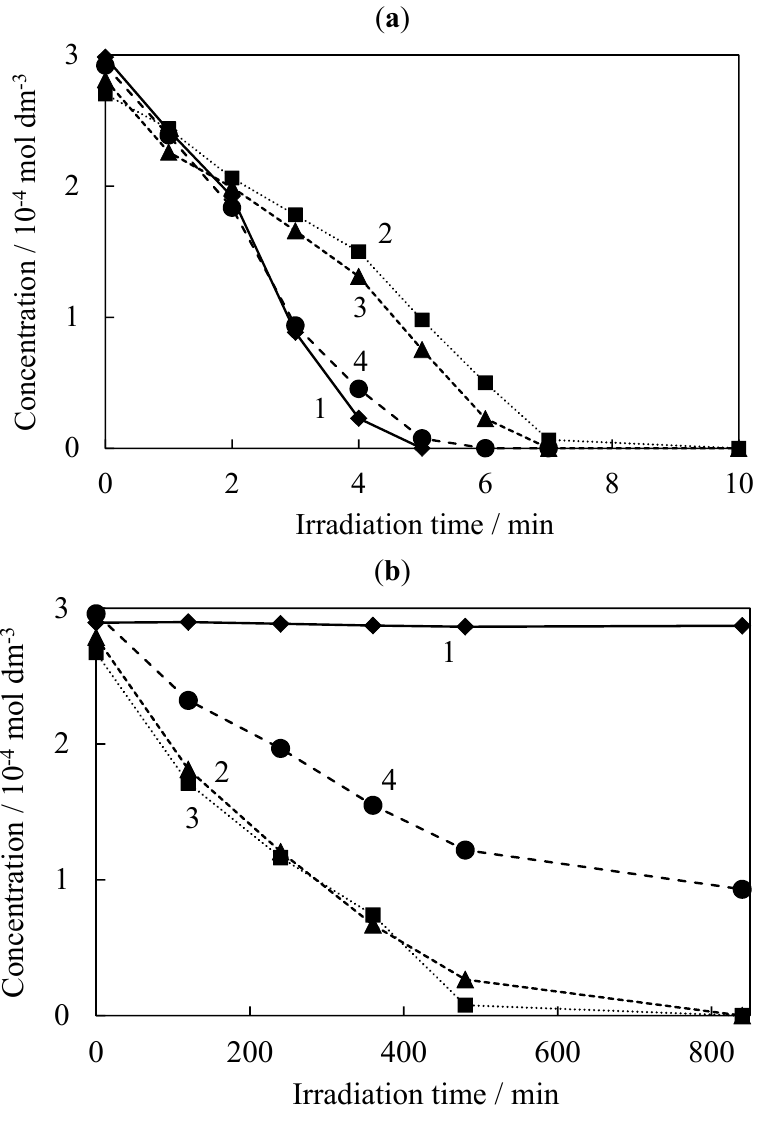
Figure 6. Time course of trichloroethylene (TCE) concentration during the photocatalytic degradation of TCE using (1) Sample T; (2) Sample S300; (3) Sample S400 and (4) Sample S600 during ( a ) UV or ( b ) visible